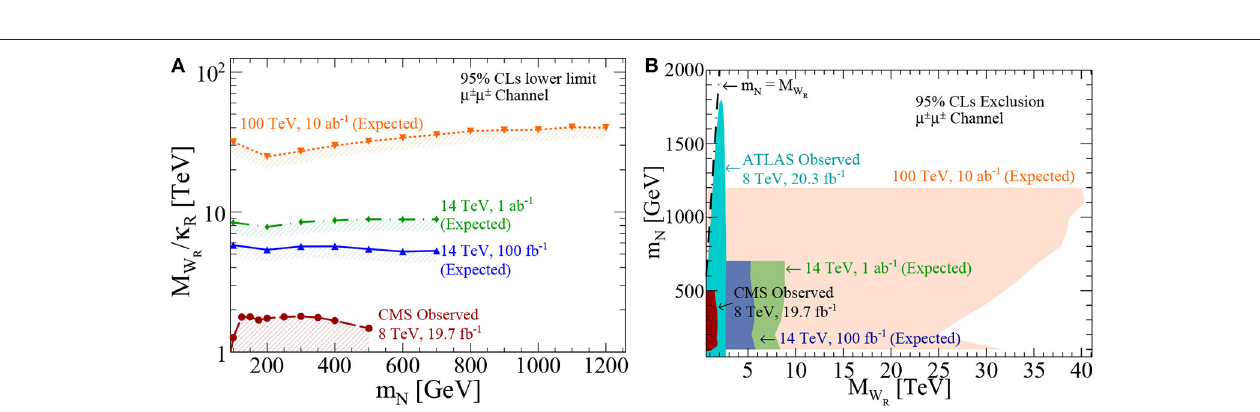
FIGURE 20 | Discovery (A,B) and 95% CL exclusion (C,D) potential of neutrino jet searches, i.e., pp shown in (C,D) , ATLAS experiment’s 8 TeV 95% CL [52] and KamLAND-Zen 90% CL [36, 402] exclusion limits. Figure from Mitra et al. [141].